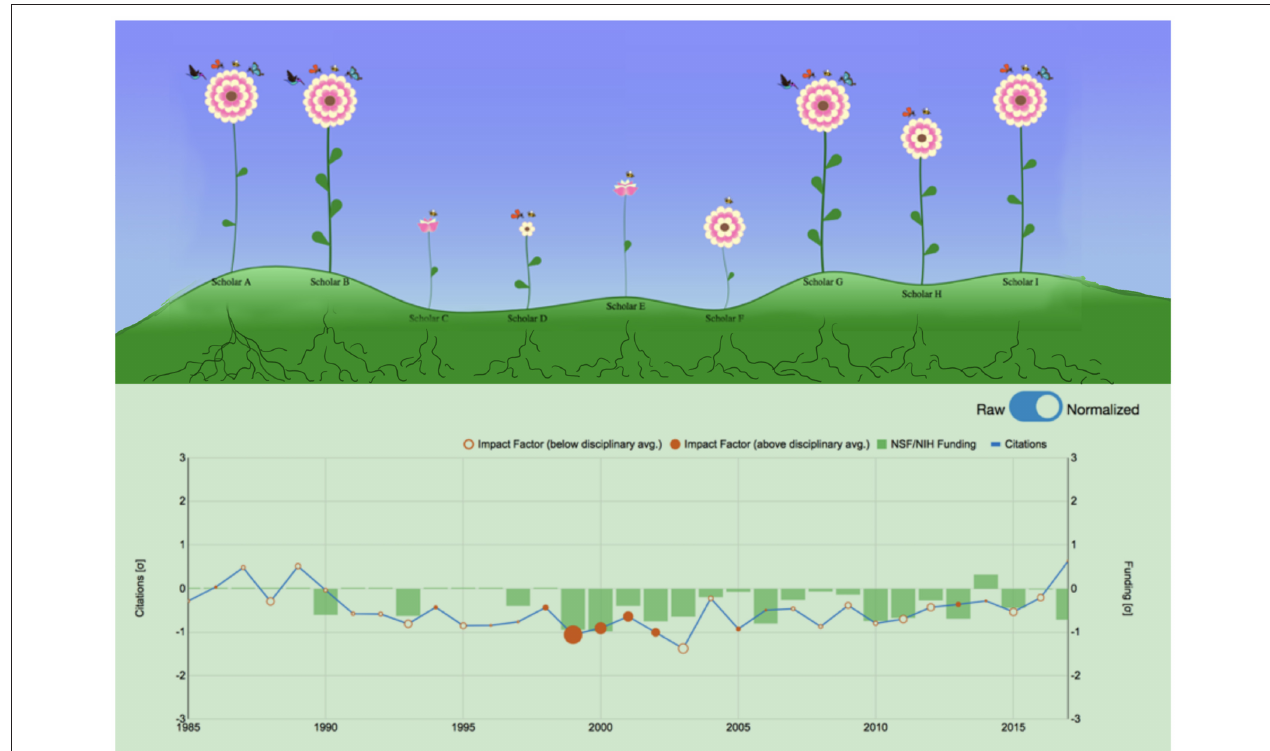
FIGURE 1 | The two faces of Scholar Plot. (Top) Iconic representation of individual faculty merit in a computer science department in the U.S. - summer 2018. (Bottom) Temporal plot representation of cumulative academic merit for the same